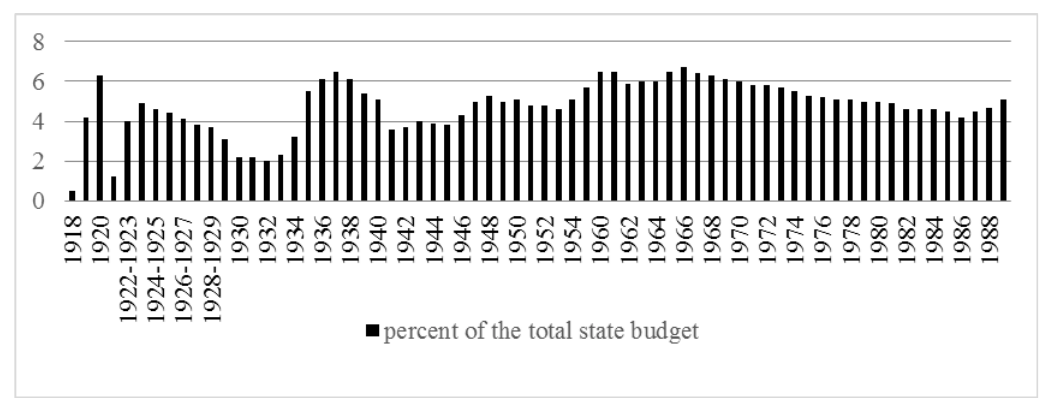
Figure 1. Government expenditure on health from the Russian Soviet Federative Socialist Republic (RSFSR) to the Union of Soviet Socialist Republics (USSR).